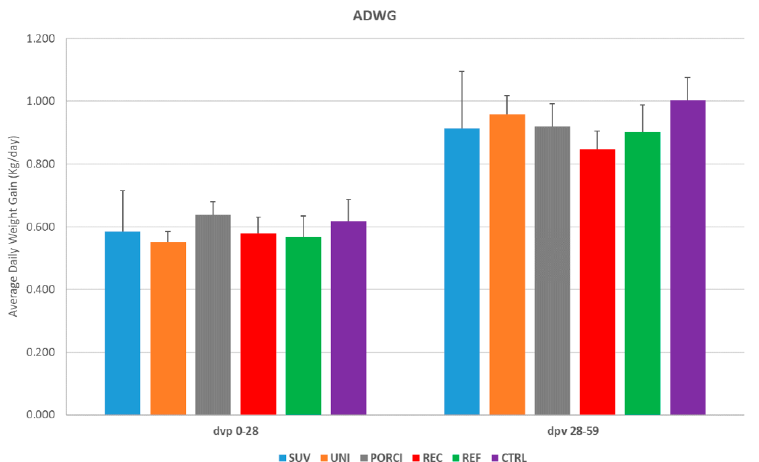
Figure 2. Average daily body weight gain (ADWG) (kg per day) from start to finish of the study at the group level. The pigs in the SUV, UNI and PORCI groups were vaccinated with the vaccine Suvaxyn PRRS, Unistrain or Porcilis PRRS at day 0 post-vaccination (dpv) and challenged at dpv 28 with the recombinant Horsens strain together with an unvaccinated group of pigs (REC). Another group of unvaccinated pigs was challenged on dpv 28 with a reference strain (REF). The control group (CTRL) was left unvaccinated and unchallenged.